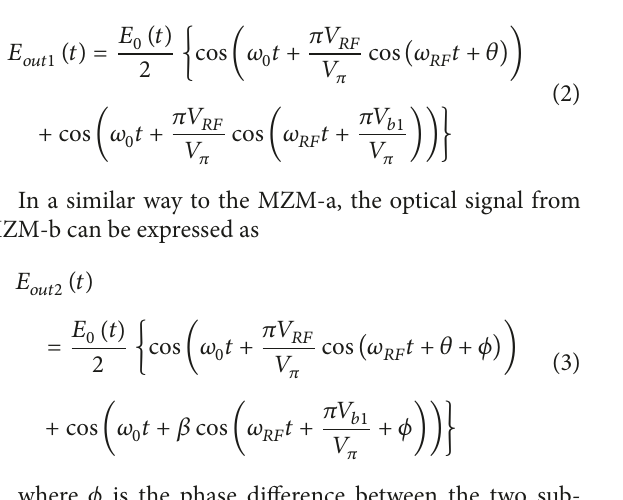
Figure 11: Electrical spectrum of 60GHz